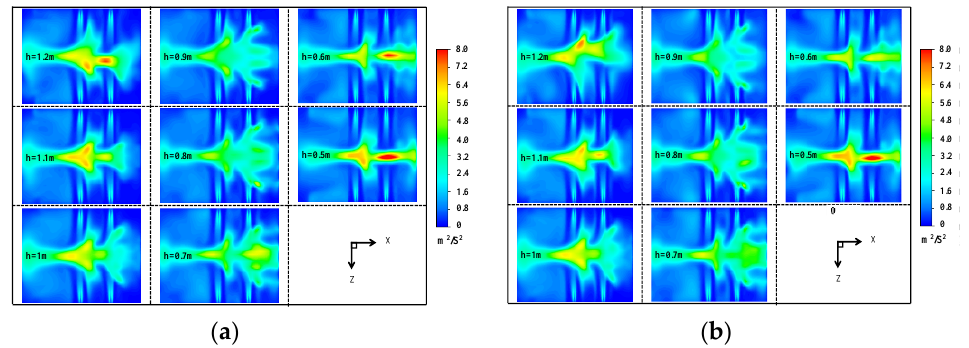
Figure 11. Turbulent energy cloud diagram of the center cross-section of the first combustion chamber under different nozzle arrangement heights (Y = 0.75 m). ( a ) The burner is symmetrically arranged with reverse swirl. ( b ) Symmetrical arrangement of burners with same direction flow.